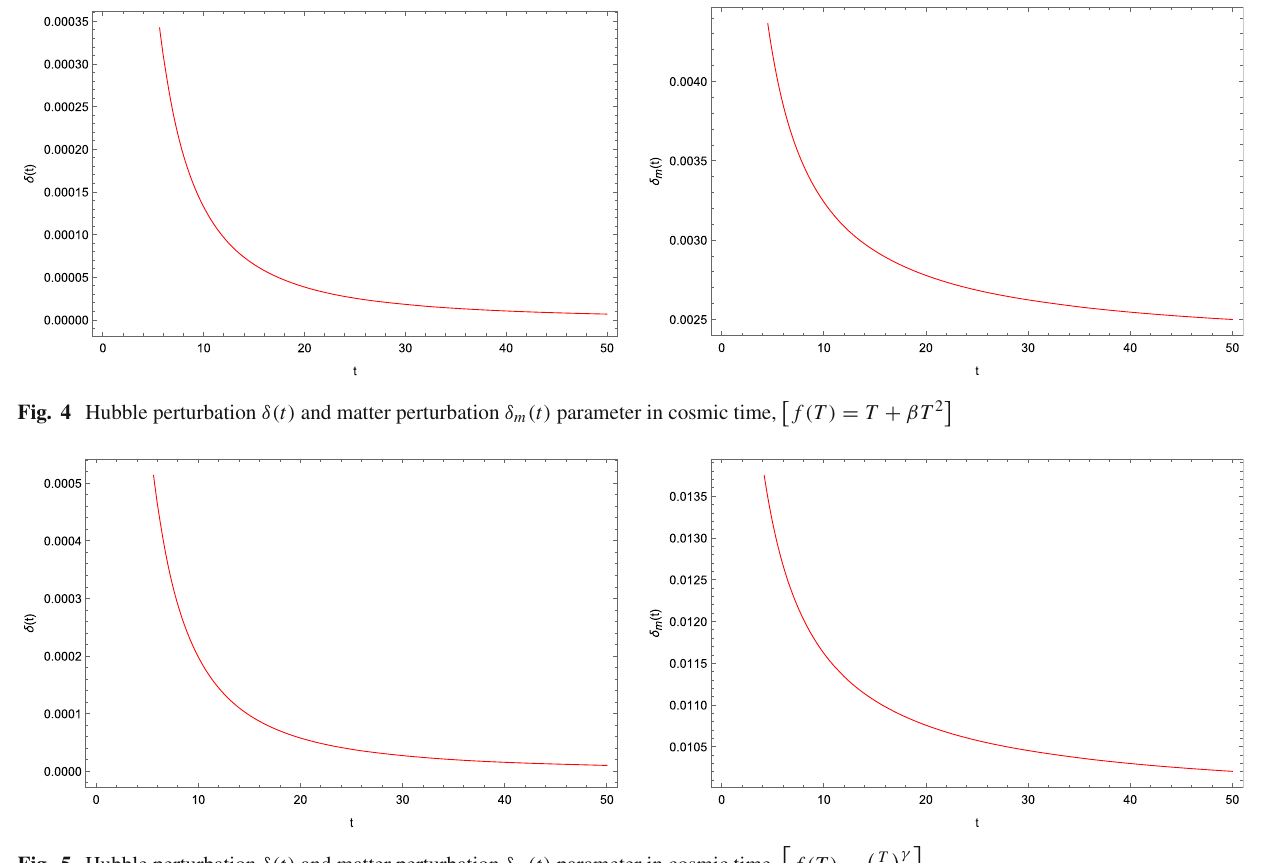
(cid:12) (cid:9) γ (cid:8) T f ( T ) = λ